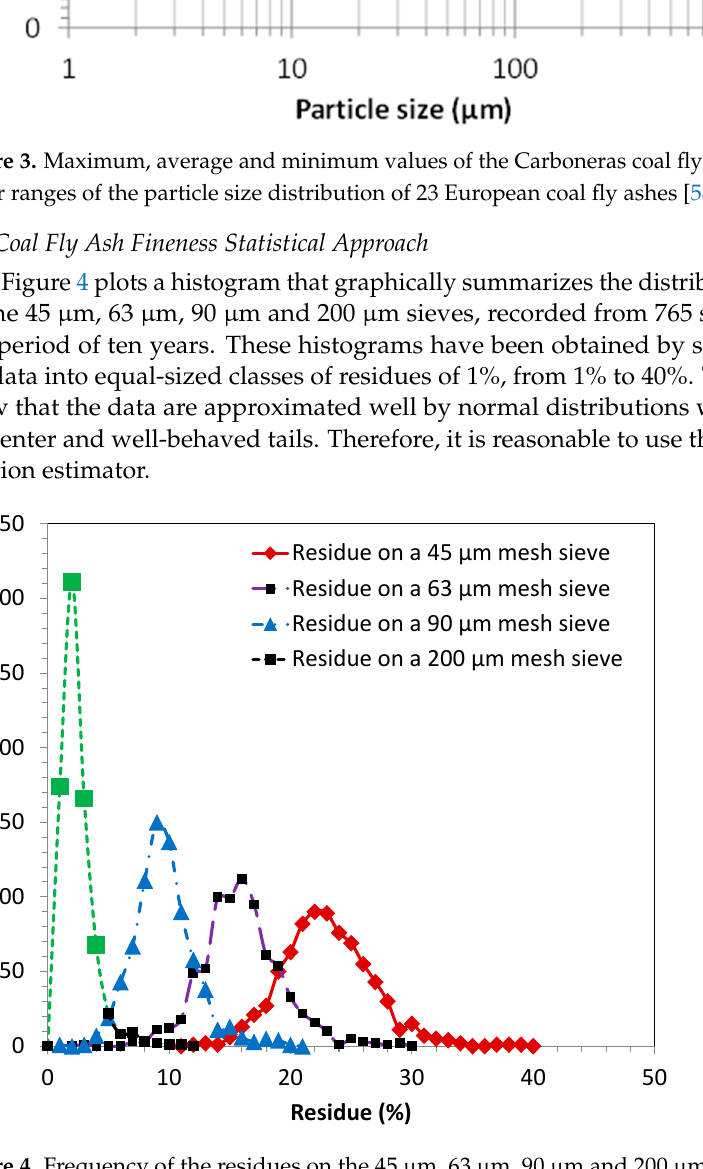
Figure 4. Frequency of the residues on the 45 µm, 63 µm, 90 µm and 200 µm sieves, recorded from 765 spot samples picked in a period of ten years.